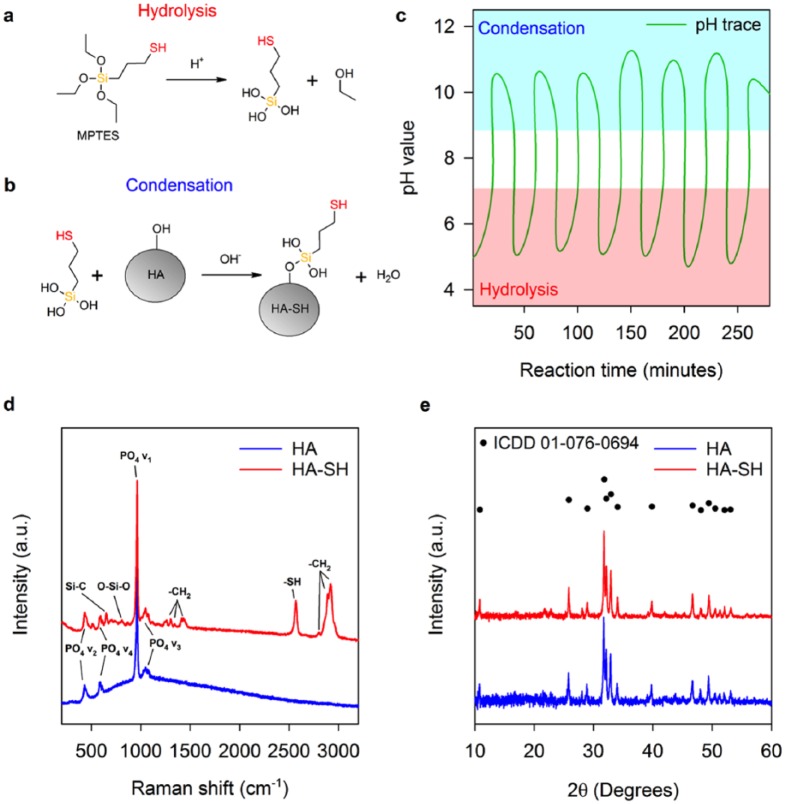
Functionalisation of HA to HA-SH with MPTES. (a) Hydrolysis and (b) condensation reactions of MPTES. (c) Reaction pH evolution. HA and HA-SH (d) Raman spectra and (e) XRD patterns.